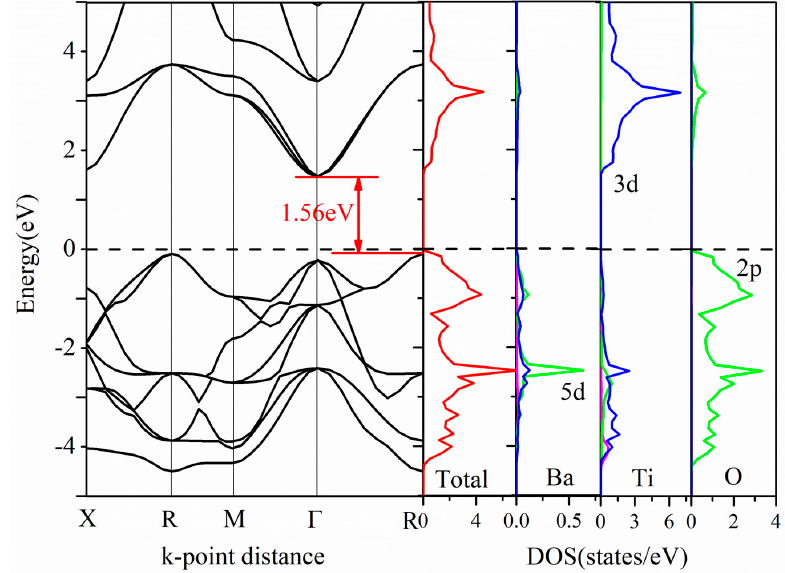
Figure 3. Band structure, total and partial density of states of pure cubic BaTiO 3 .